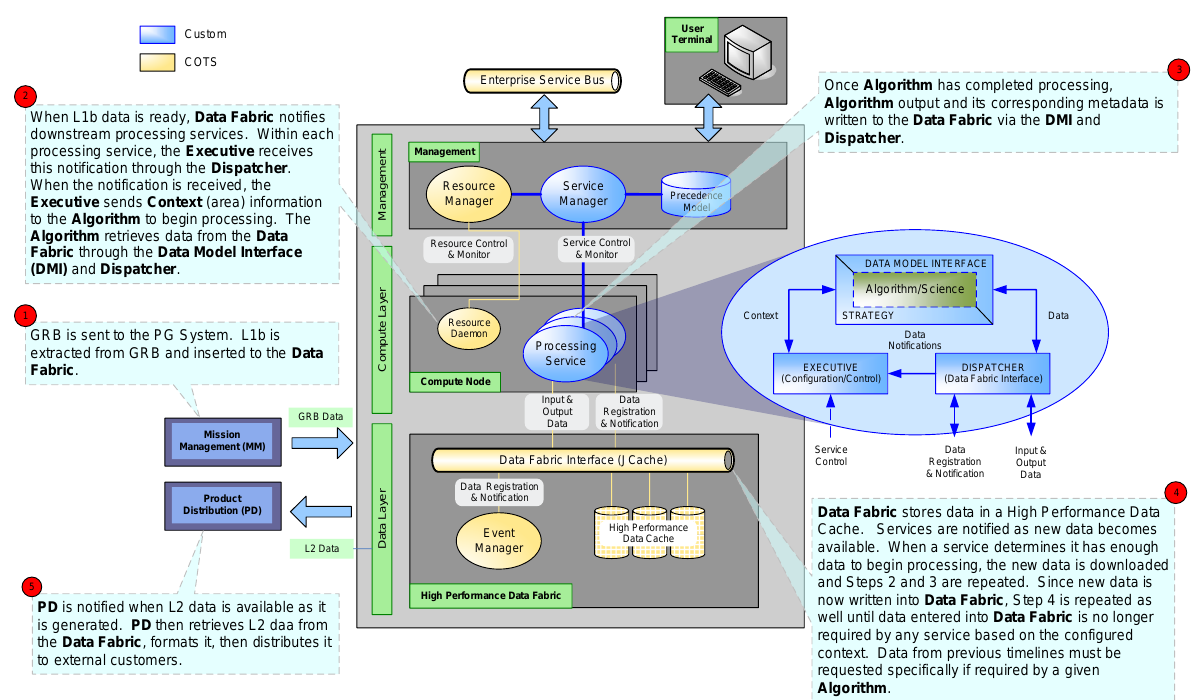
Figure 3. The Product Generation and Distribution Architecture and Data Flows at